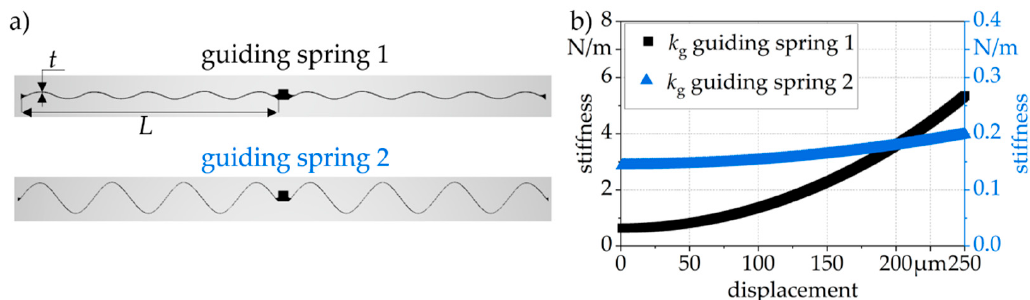
Figure 4. ( a ) Geometry of the guiding springs 1 and 2; ( b ) stiffness of guiding springs 1 and 2 based on solid state COMSOL Multiphysics simulation.